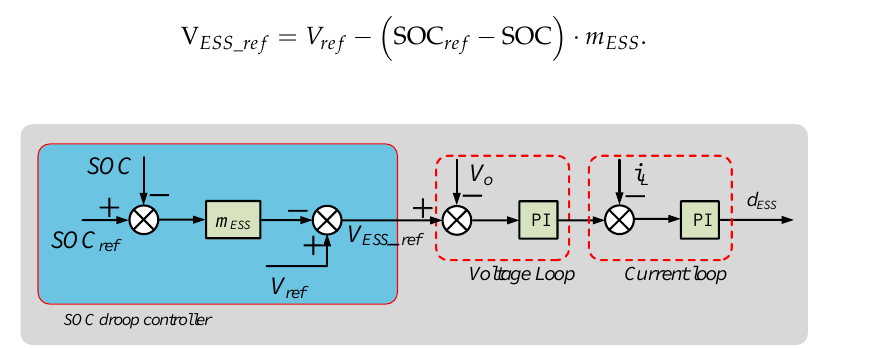
Figure 9. SOC-based energy storage droop controller.